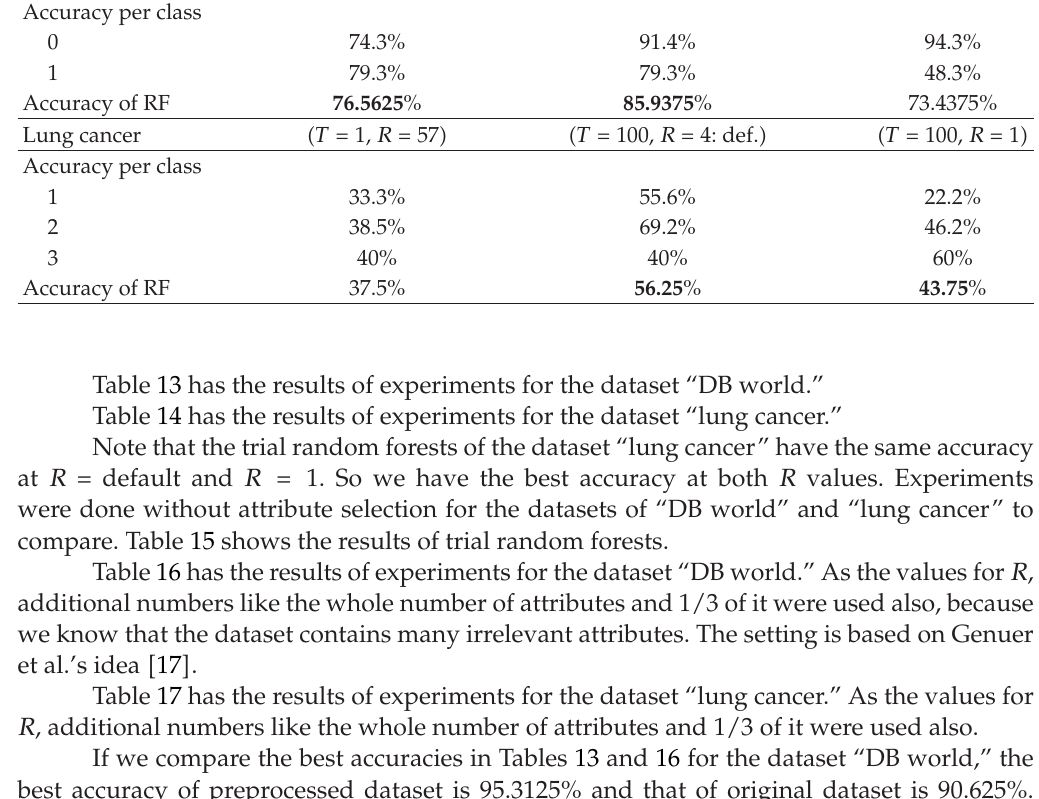
Table 15: The accuracy of trial random forests (cid:6) RF (cid:7) for each class with di ff erent parameters.